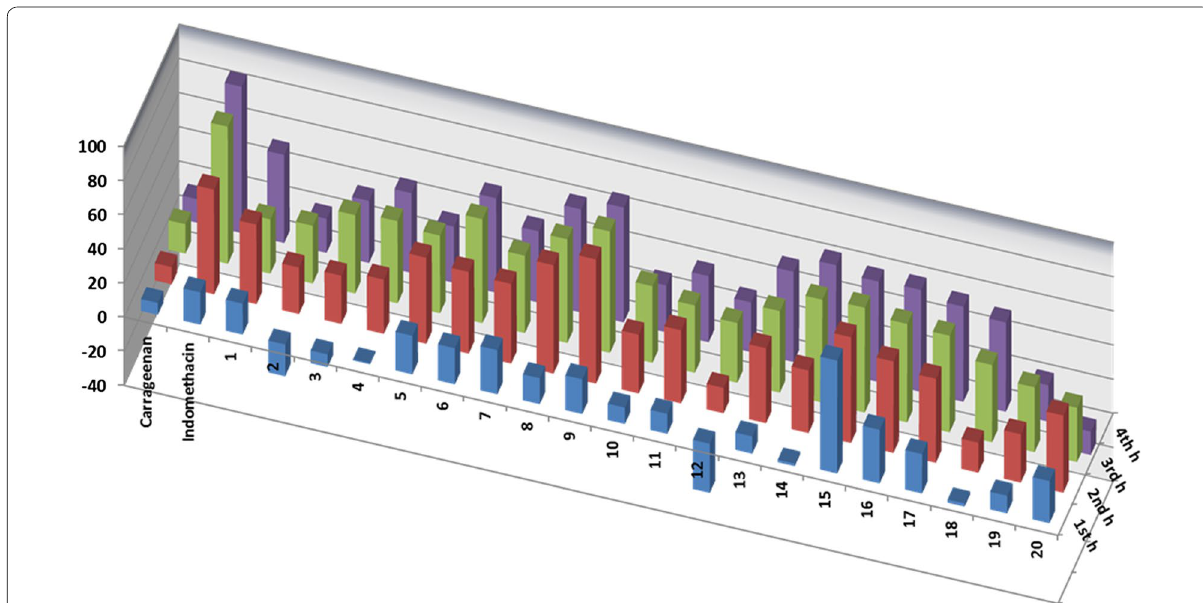
Fig. 1 Reduction of rat’s paw edema induced by carrageenan after administration of tested compounds